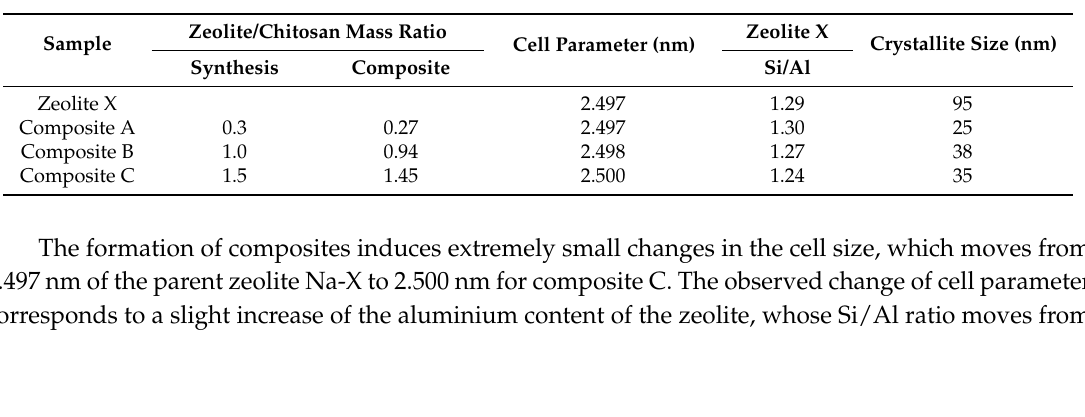
Figure 1. XRD patterns of chitosan ( ch ); chitosan-zeolite composites A ( a ); B ( b ) and C ( c ); and zeolite Na-X ( zx ). Table 1. Composition of the composites and properties of the zeolitic component.